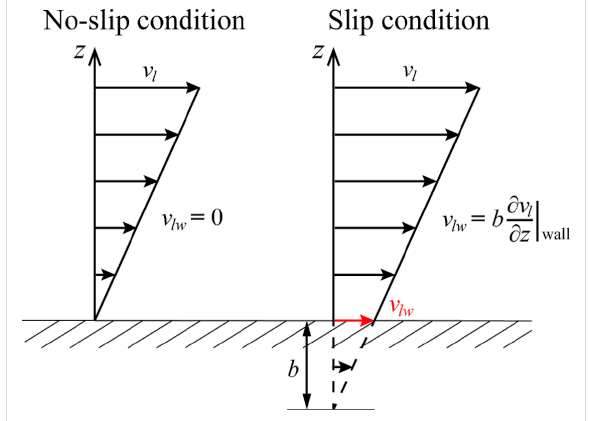
Figure 1: Simplified schematic of the no-slip and slip conditions. ν lw is the relative velocity between the wall and the adjacent liquid, ν l is the velocity field of the liquid, b is the slip length, and is the liquid velocity gradient in the direction perpendicular to the wall.